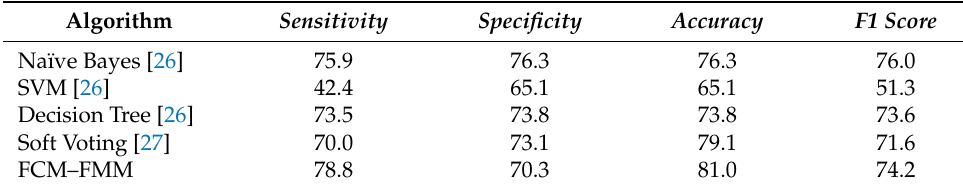
Table 8. Performance comparison summary from the